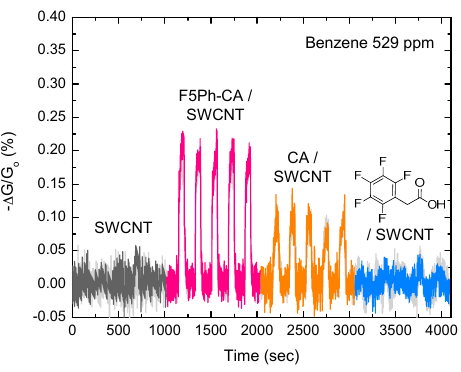
Figure 6. Normalized conductance changes of SWCNT, F5Ph-CA/SWCNT, CA/SWCNT, and 2,3,4,5,6-pentafluorophenylacetic acid/SWCNT) systems toward 529 ppm of benzene